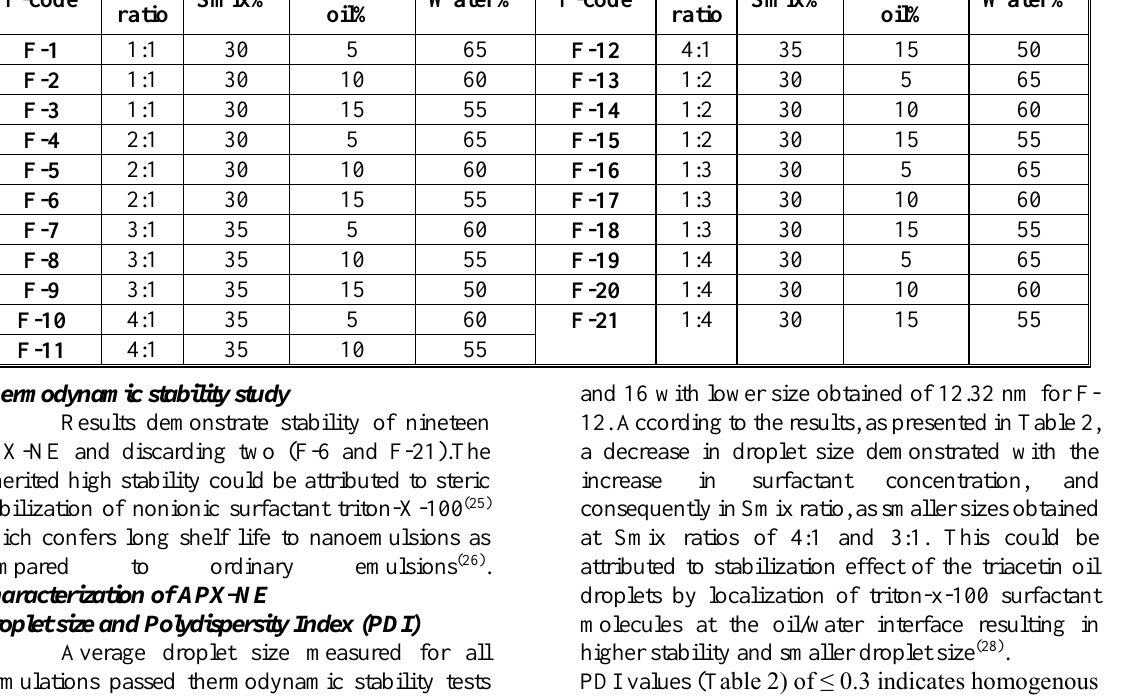
Table 1. Composition (w/w %) of apixaban nanoemulsion formulations F-code